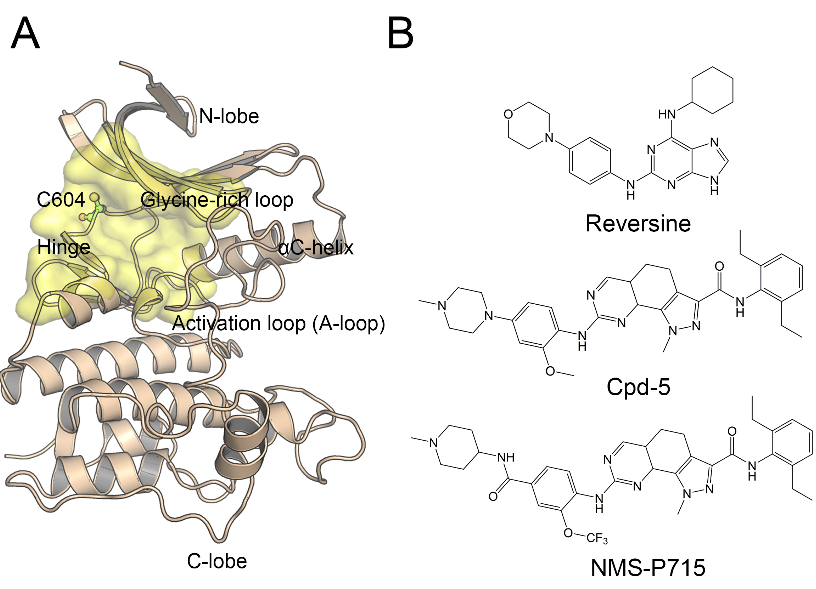
Figure 1. Structure of Mps1 and representative inhibitors. ( A ) Overview of Mps1 structure (PDB code: 5NTT), C604Y mutation is colored green ball-and-stick model. The binding pocket is the colored yellow surface; ( B ) Chemical structures of reversine, Cpd-5, and NMS-P715.